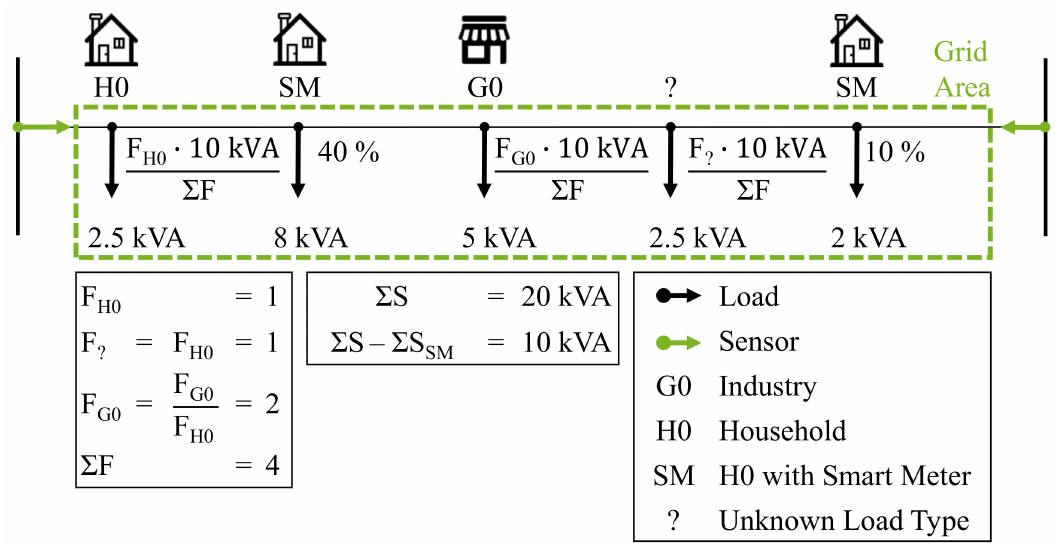
Figure 4. One example of a load distribution in a low voltage grid area at a time step with a relation between the G0 and the H0 standard load profiles of